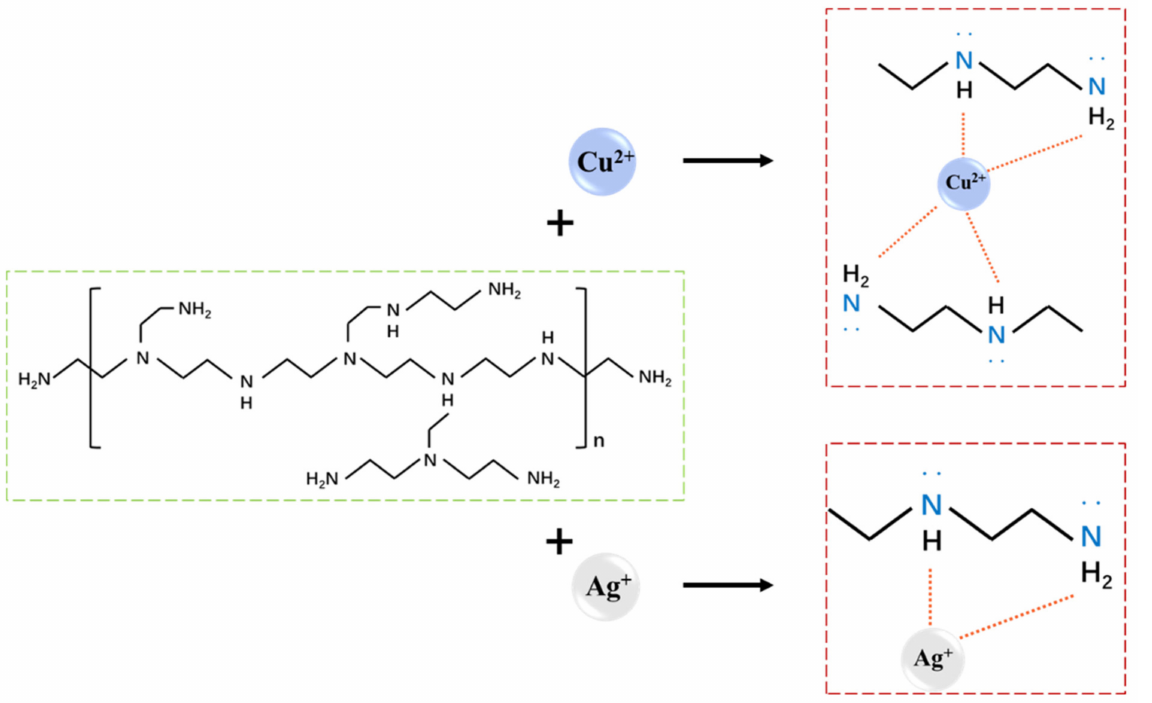
Figure 9. Schematic diagram of the molecular structure of PEI and its coordination process with Cu 2+ and Ag +